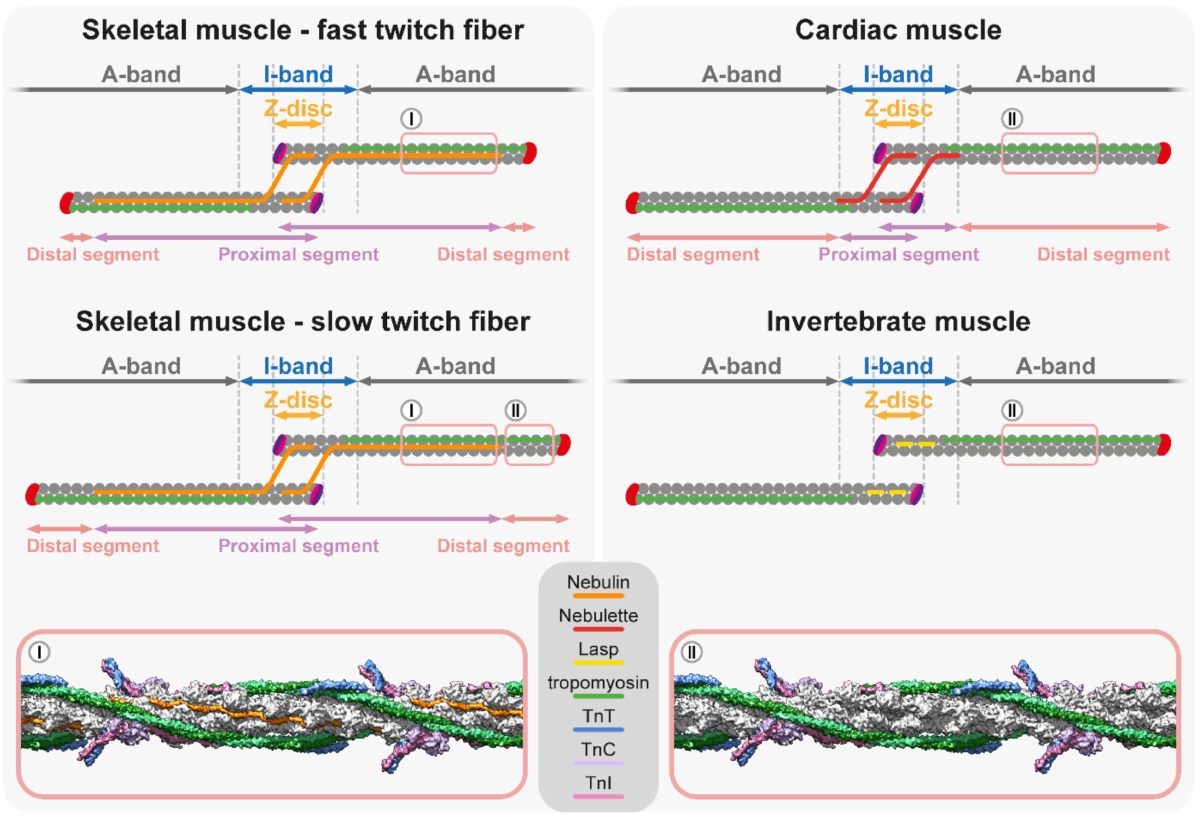
Figure 4. Length regulation and the two-segment model of thin filaments. Schematics at the top depict the two-segment model: in muscles with short distal thin filament segments (fast twitch), the length of nebulin determines the length of the thin filament by interacting with and stabilizing every actin monomer in the proximal segment. In muscles with long distal thin filament segments (slow twitch) and in cardiac muscles, the thin filament length is primarily mediated by the interplay between Tmod and Lmod at the pointed end and the role of nebulin and nebulette is only secondary. Similarly, in invertebrate ( Drosophila ) muscles, thin filament length is thought to be regulated by the interplay between Tmod and SALS, and the nebulin repeat protein Lasp is only secondary. Note that Lasp is likely to also be present in the A-band, however, in the flight muscle, it is only detected in the Z-disc. The molecular models at the bottom demonstrate that nebulin (colored in orange) is present in the grooves between the two strands of the F-actin helix in the A-band region of thin filaments [196]; PDB: